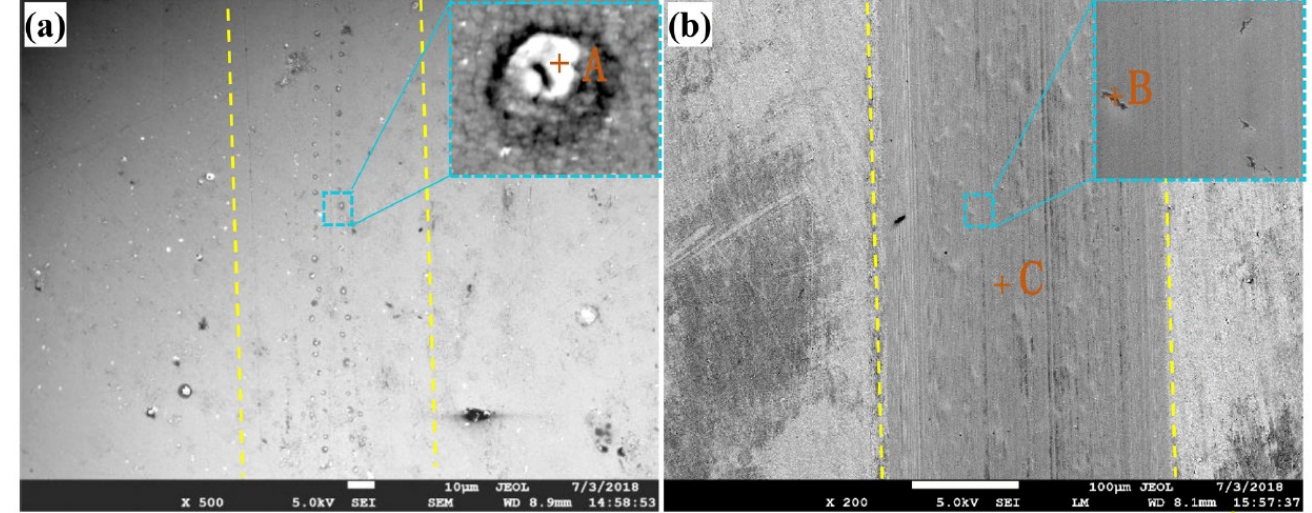
Figure 10. Wear morphology of ( a ) Cr-doped GLC coating, ( b ) Cu-doped GLC coating. +A, +B, and +C are locations for EDS analysis (Reprinted from Applied Materials and Interfaces, 10(42), X. Sui, R. Xu, J. Liu, S. Zhang, Y. Wu, J. Yang, and J. Hao, Tailoring the Tribocorrosion and Antifouling Performance of (Cr, Cu)-GLC Coatings for Marine Application, 36531–36539, Copyright (2018), with permission from American Chemical Society (ACS).)